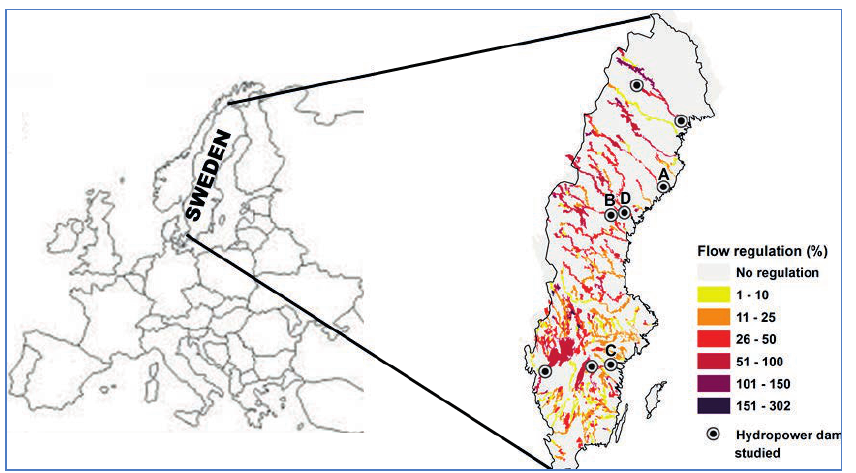
Fig. 1 Map showing degree of up-stream flow regulation of annual water-discharge volume in Swedish rivers. The eight hydropower dams studied in greater detail are marked, and letters refer to illustrated results below (Figs